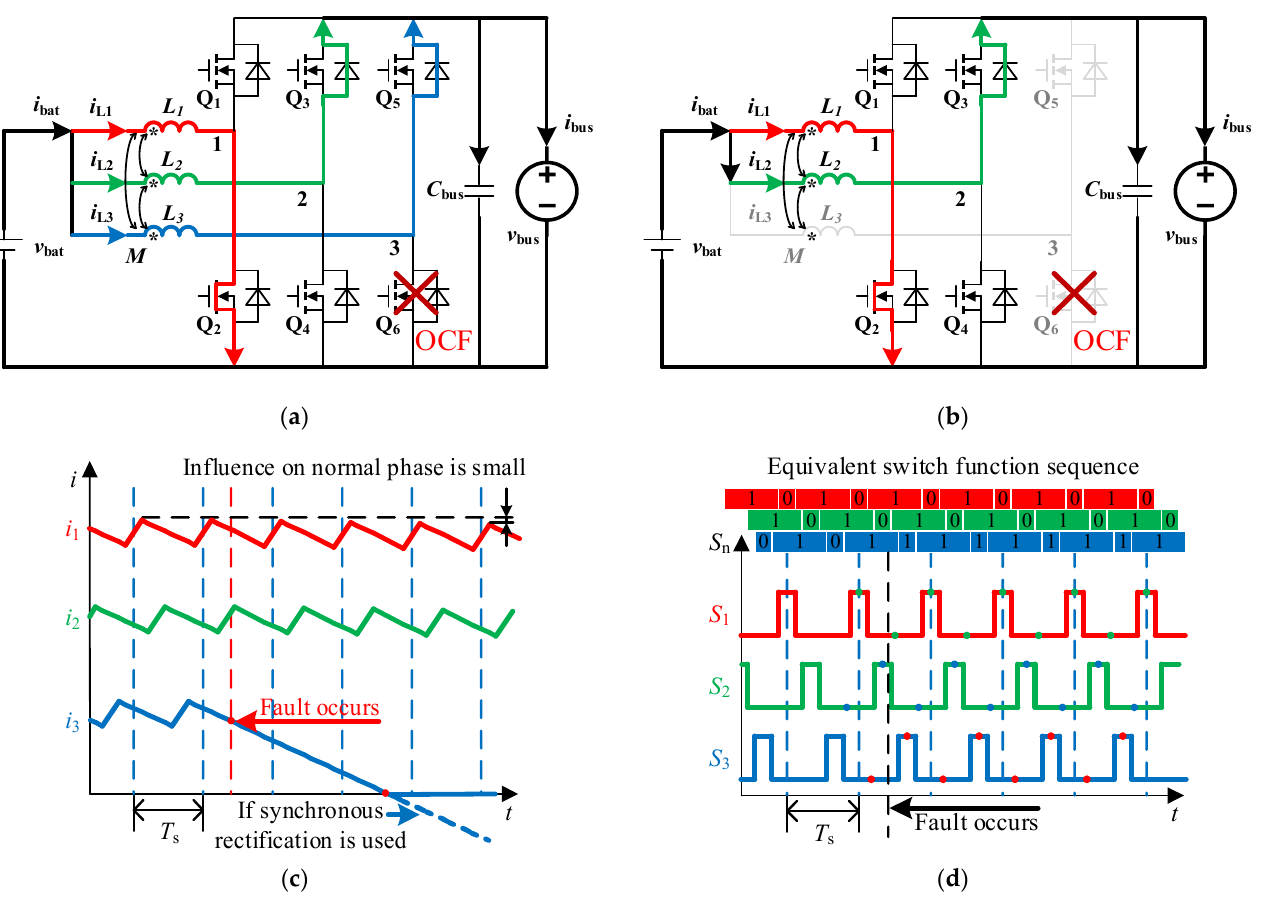
Figure 2. The waveform diagram of the phase current after OCF. ( a ) Currents diagram when S 1 = 0, S 2 = 1, S 3 = 1 after OCF. ( b ) Currents diagram when S 1 = 0, S 2 = 1 after i L3 is 0. ( c ) Change in phase current. ( d ) Change in switch function sequence.